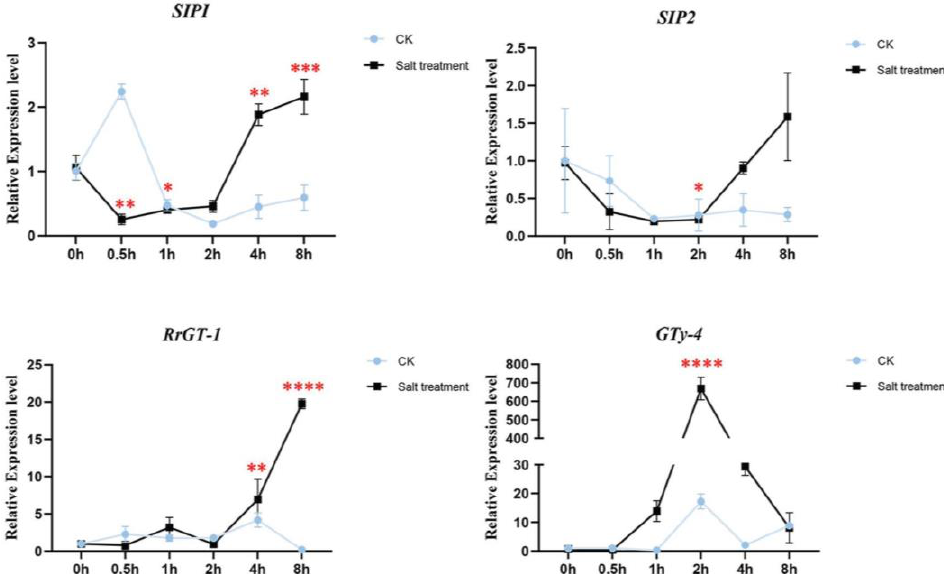
Figure 5. The salt responsive expression levels of RrGTγ -4 , RrSIP1 , RrSIP2 and RrGT-1 in roots of R. rugosa . The wild R. rugosa seedings were treated by water (CK) and 340 mM NaCl solution (Salt treatment) from 0.5 h to 8 h. Untreated seedings were the reference samples (0 h). *, **, *** and **** indicated the threshold value of significance of t -test 0.05, 0.01, 0.001 and 0.0001, respectively.